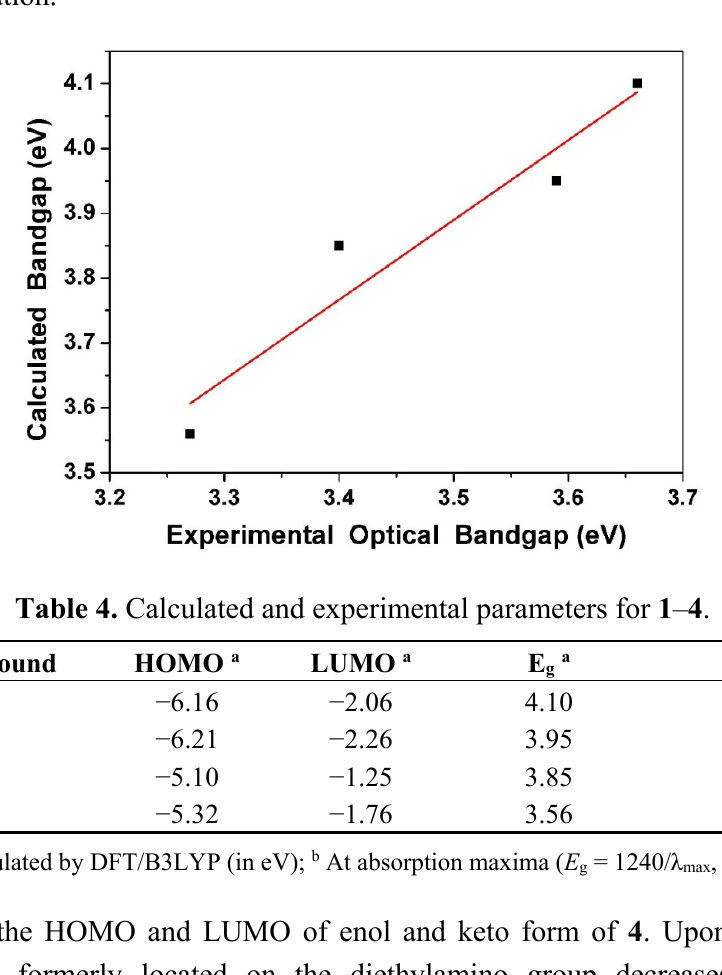
Figure 11. Plot of calculated optical bandgap (eV) in the gas phase ν s. experimental optical bandgap in solution.